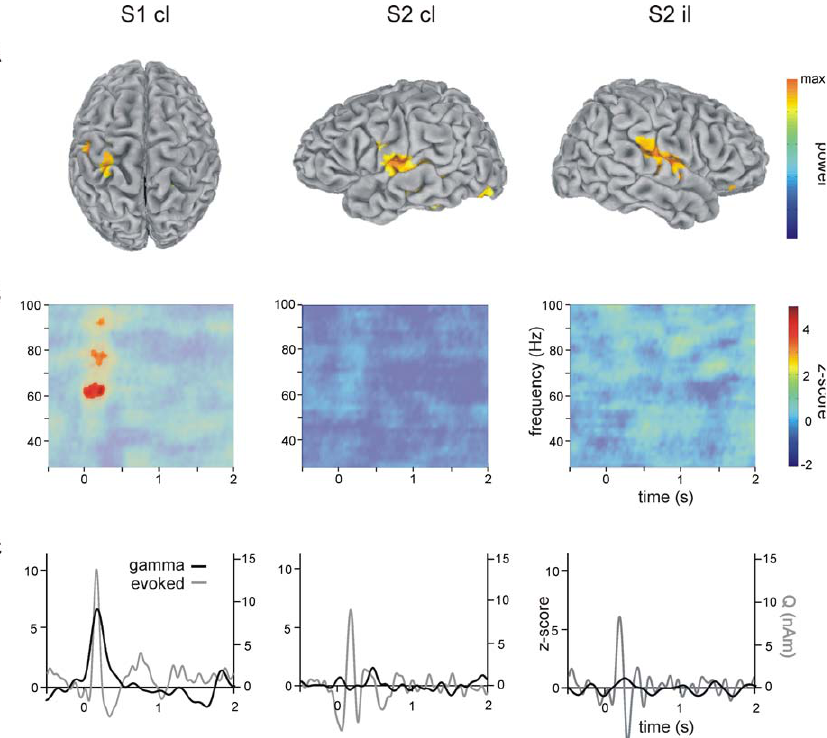
Figure 1. Pain-Induced Gamma Oscillations in Somatosensory Cortices (A) Group mean locations of contralateral primary (S1 cl) and bilateral secondary somatosensory (S2 cl and S2 il) cortices. Locations were obtained from analysis of evoked responses to noxious laser stimuli. Individual tomographic maps of pain-evoked power increases were calculated and